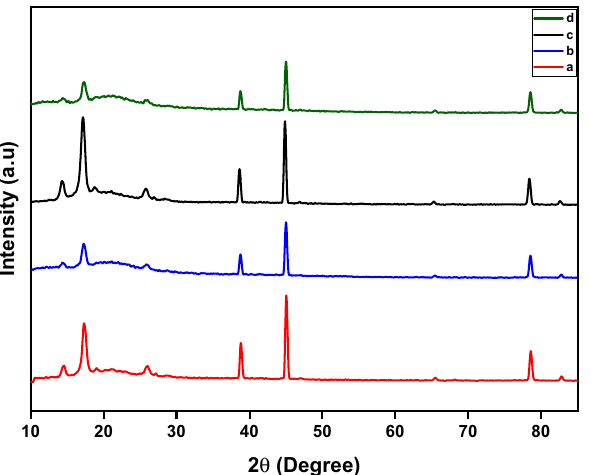
Figure 4. X-ray Diffraction (XRD) for various packaging was used in this study. ( a ): XRD analysis of the package without nano clay and any treatment, ( b ): XRD analysis of the package containing nano clay and without any treatment, ( c ): XRD analysis of the package without nano clay and after the cold plasma treatment, ( d ): XRD analysis of the package containing nano clay and after the cold plasma